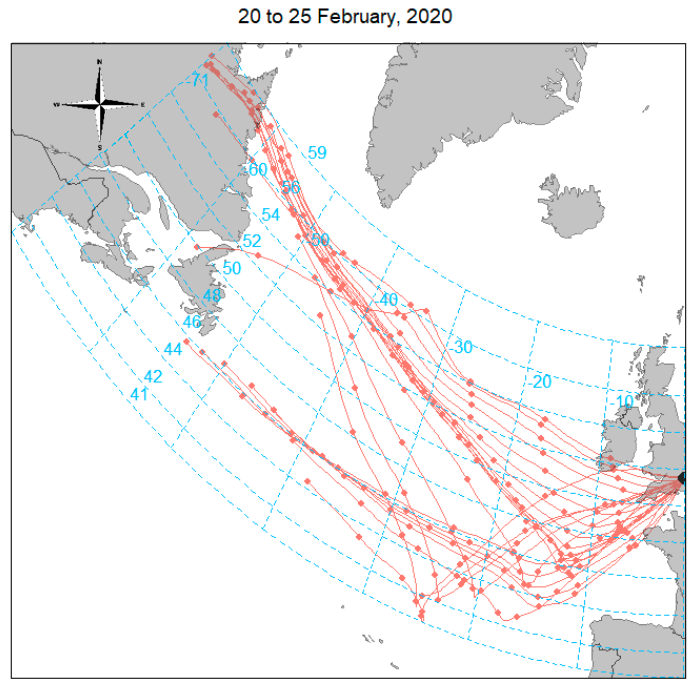
Figure 7. Hysplit back trajectories centred on the UK for 6 days in April (20 to 25 April) ( upper-panel ) and 6 days in February (20 to 25 February) 2020 ( lower-panel ).